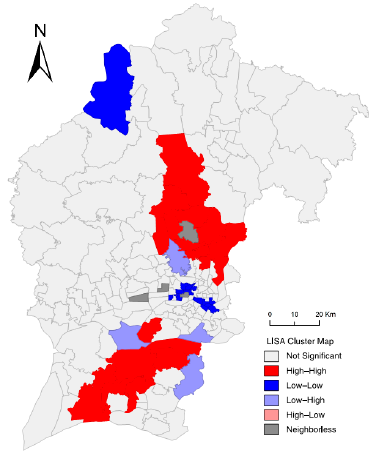
Figure 4. LISA clusters of residential burglary.